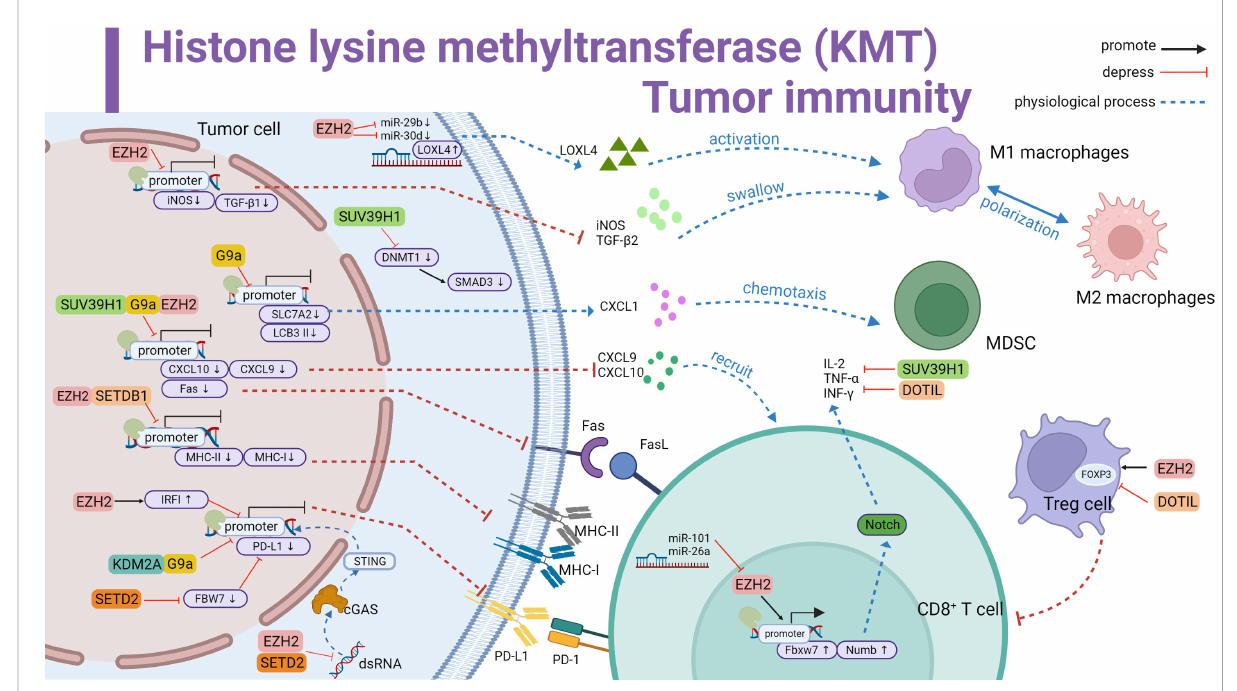
FIGURE 1 Histone lysine methyltransferase (KMT) involved in tumor immune summary. Promotes LOXL4 upregulation by antagonizing miR-29b and miR- 30d to activate macrophage polarization; downregulates iNOS and TGF- b 1 and inhibits macrophage phagocytosis. Downregulates iNOS and TGF- b 1, inhibits macrophage phagocytosis. G9a inhibits SLC7A2, upregulates CXCL1 and thus recruits MDSC. G9a inhibits LCB 3II transcription and promotes immune escape. SUV39H1, G9a and EZH2 inhibit CXCL10 and CXCL9 transcription and reduce T cell recruitment. Meanwhile inhibit Fas transcription and curb Fas-FasL signaling pathway activation. EZH2 and SETDB1 repress MHC-II and MHC-I to affect antigen recognition. KDM2A and G9a directly repress the initiation of PD-L1 transcription. EZH2 and SETD2 inhibit the dsRNA-cGAS-STING pathway in the cytoplasm affecting PD-L1 transcription. In addition, EZH2 upregulates IRF1 to inhibit PD-L1 transcription. SETD2 downregulates FBW7 to inhibit PD-L1 expression. SUV39H1 inhibits SMAD3 in the cytoplasm and forms immunosuppression. EZH2 promotes FOXP3 transcription and Treg cell suppressor function. In contrast, DOTIL is the opposite. In T cells, EZH2 upregulates IL-2,TNF- a and INF- g by promoting Fbxw7 and Numb activation of the Notch pathway, a process inhibited by miR-101 and miR-26a antagonism. SUV39H1 and DOTIL suppress the expression of immune factors. Black line represents promotion, red line represents inhibition, and dashed line represents physiological